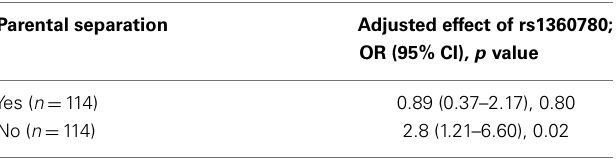
Table 4 | Stratification of association between FKBP5 and psychotic disorder by parental separation .